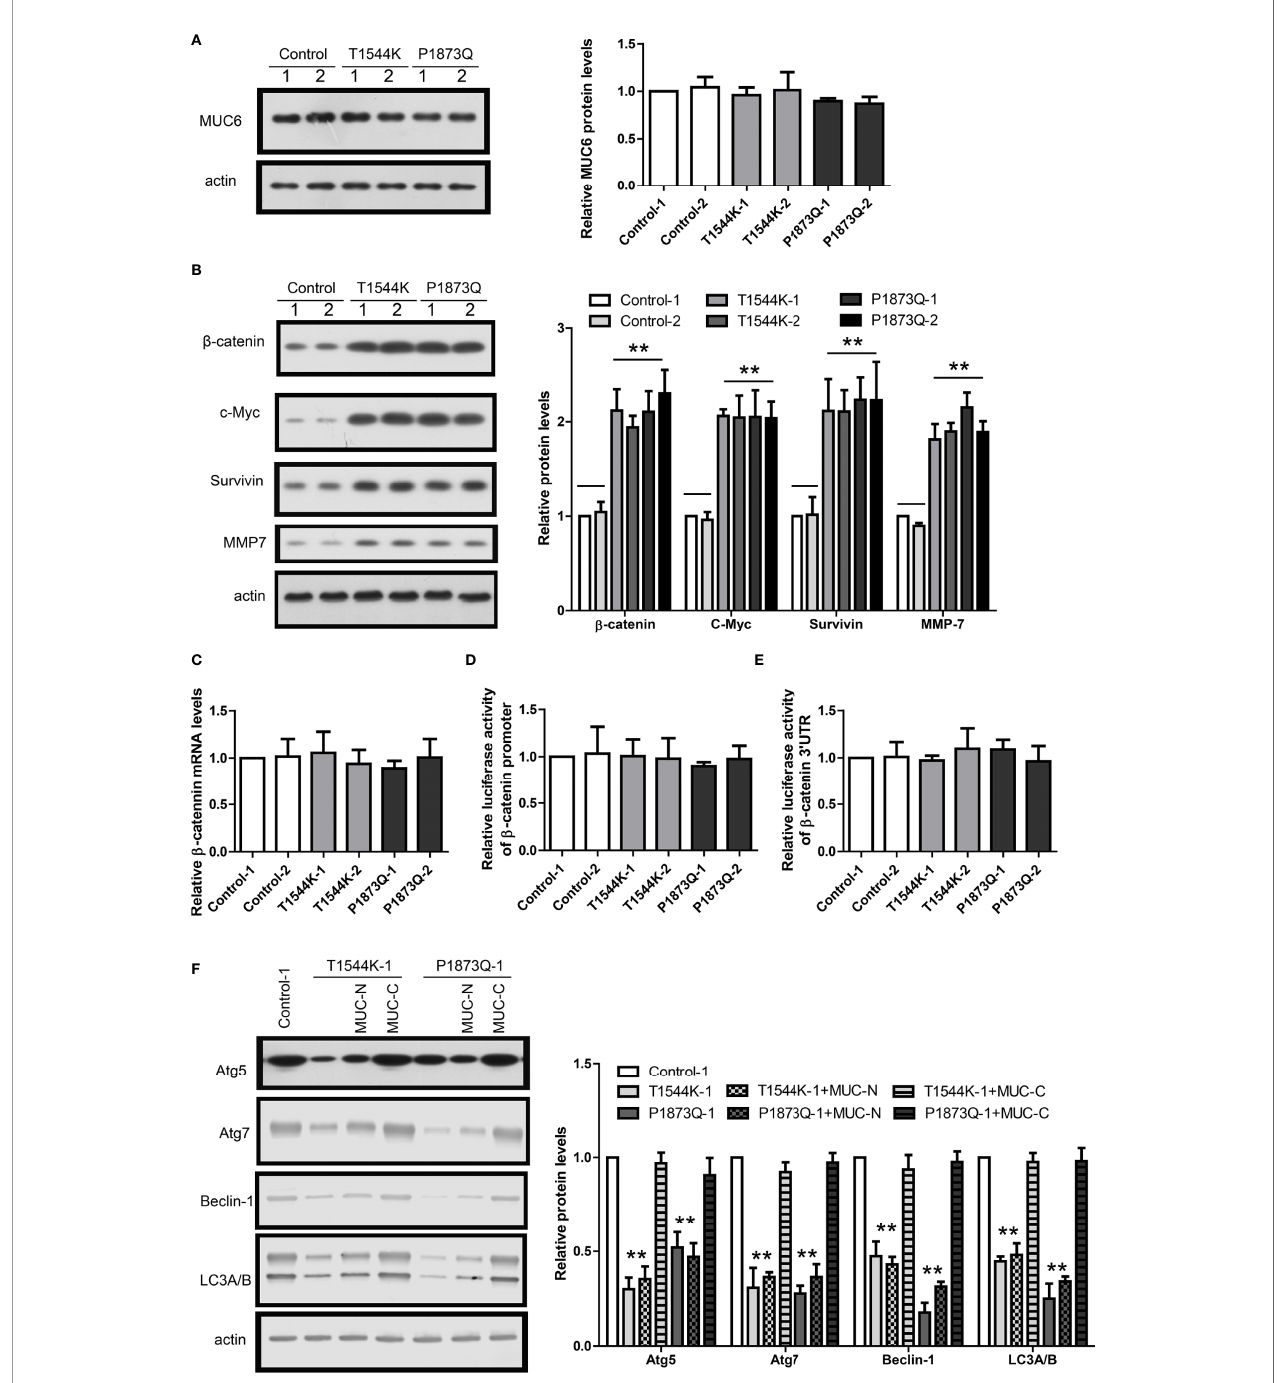
FIGURE 6 | MUC6 mutations compromise autophagy-dependent b -catenin degradation. (A) Immunoblots showing MUC6 protein levels in two clones from isogenic control, T1544K mutant and P1873Q mutant WiT49 cells, respectively. (B) Immunoblots showing b -catenin, c-Myc, Survivin and MMP7 protein levels in two clones from isogenic control, T1544K mutant and P1873Q mutant WiT49 cells, respectively. (C) Real-time PCR results showing b -catenin mRNA levels in two clones from isogenic control, T1544K mutant and P1873Q mutant WiT49 cells, respectively. (D) Luciferase assays showing the activity of b -catenin promoter in two clones from isogenic control, T1544K mutant and P1873Q mutant WiT49 cells, respectively. (E) Luciferase assays showing the activity of b -catenin 3 ’ UTR in two clones from isogenic control, T1544K mutant and P1873Q mutant WiT49 cells, respectively. (F) Immunoblots showing the effects of MUC-N or MUC-C over-expression on Atg5, Atg7, Beclin-1 and LC3A/B protein levels in one clone from isogenic control, T1544K mutant and P1873Q mutant WiT49 cells, respectively. For all,